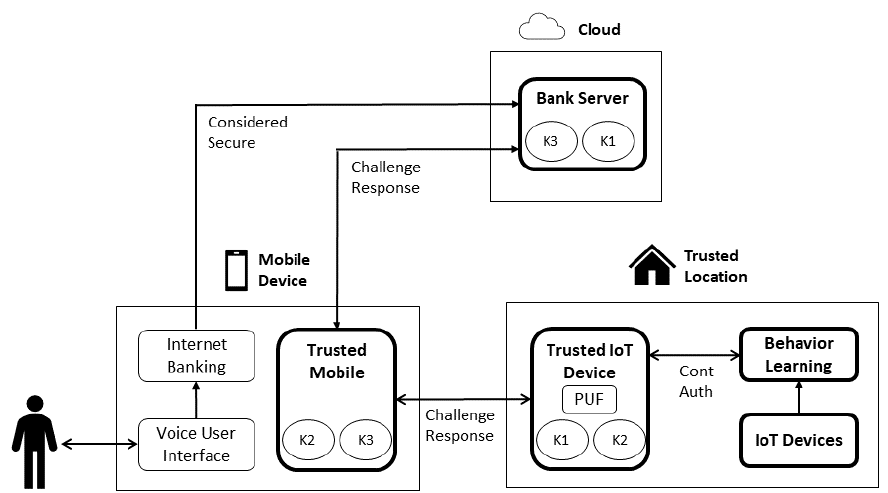
Figure 6. Non-invasive authentication